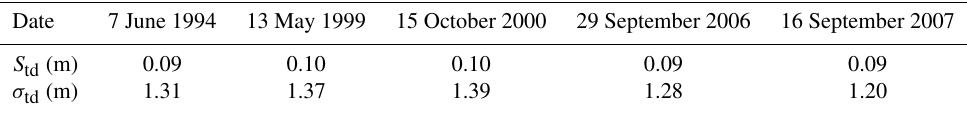
Table 5. Standard deviations S td of the tide fluctuations gauged at a nearby station and the related tide uncertainties σ td for Lido Signorino